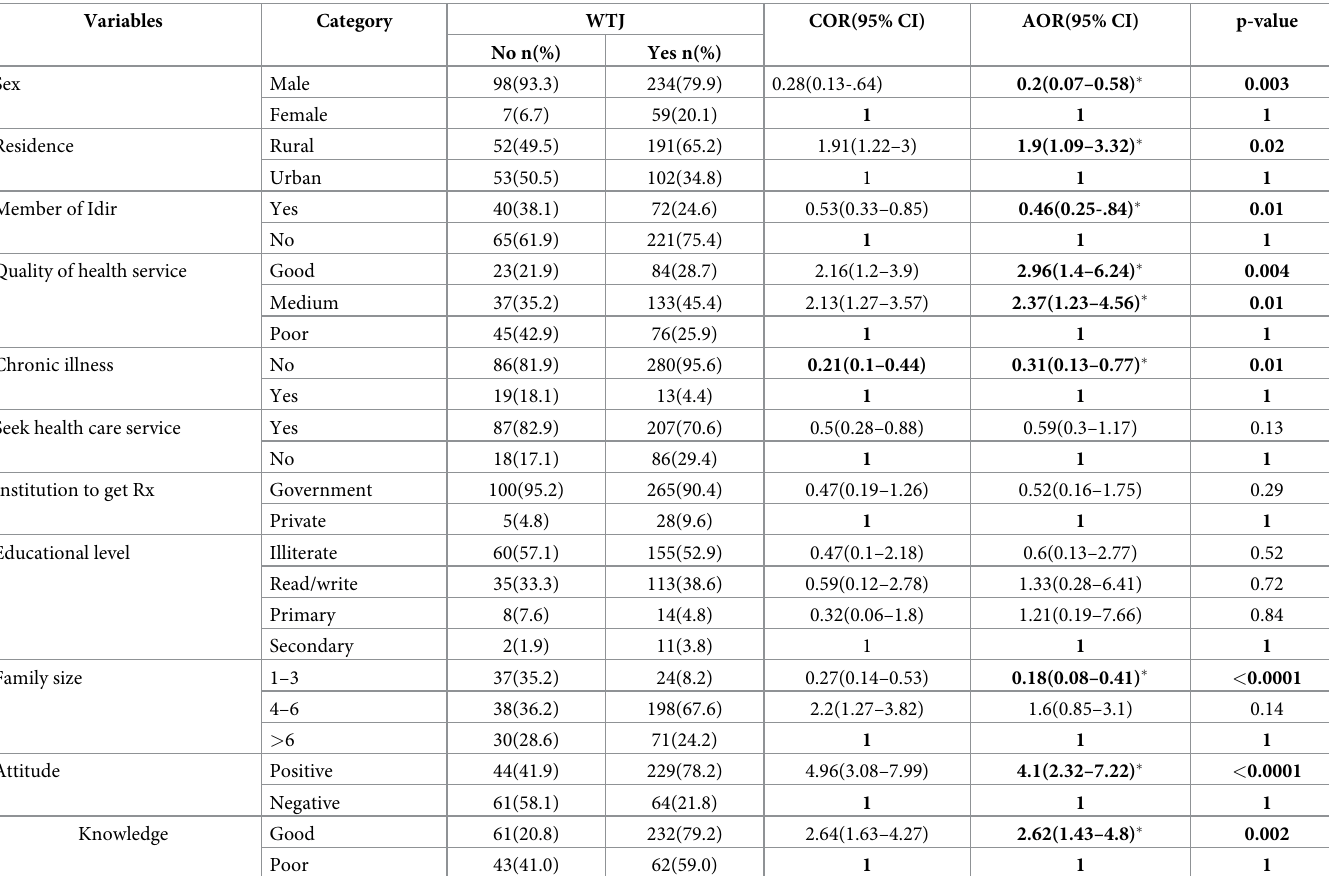
Table 2. Factors associated with willingness to join community-based health insurance program among households in WerebBabu district, Northeast Ethiopia July,